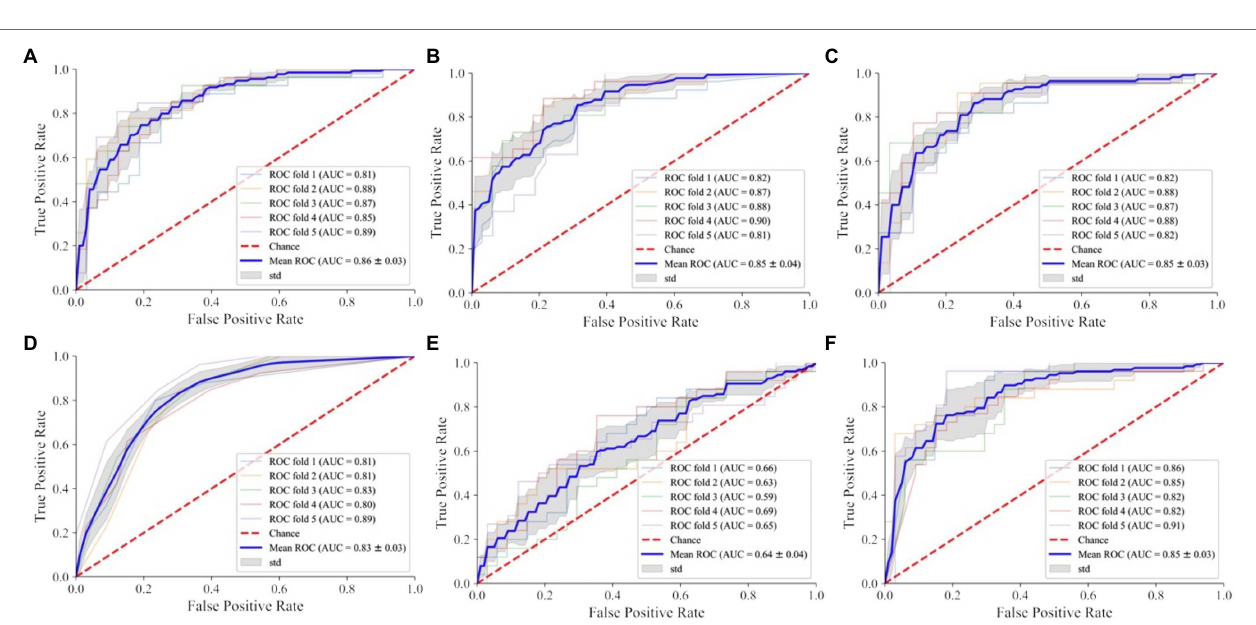
FIGURE 2 | Feature screening of the Medal Model. (A) The figure of test MSE by lambda value; (B) the path diagram of lasso regression